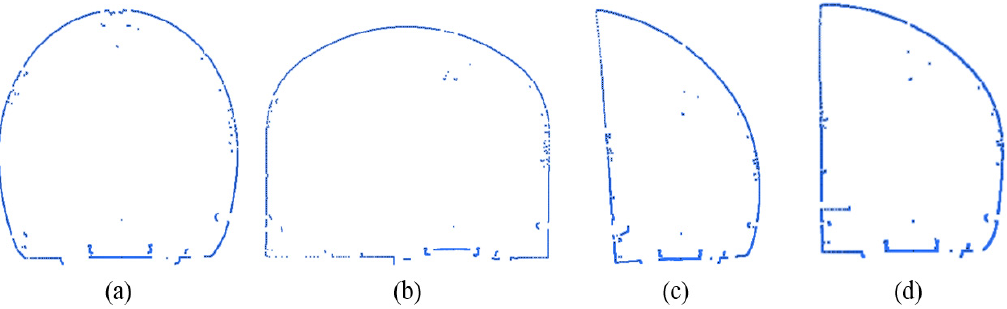
Figure 4. Different section types of mining tunnel: ( a ) horseshoe tunnel; ( b ) straight-wall circular arch tunnel; ( c ) similar rectangular tunnel A; ( d ) similar rectangular tunnel